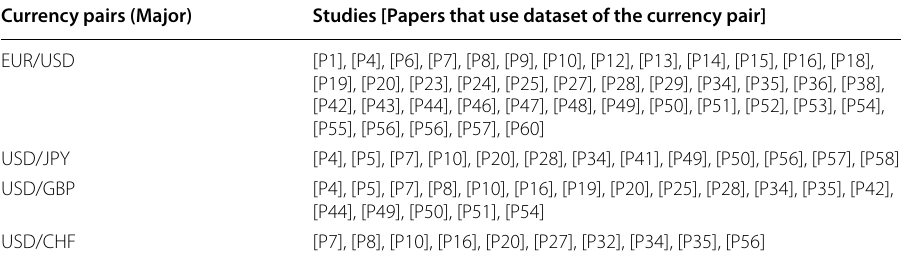
Table 7 Major currency pairs and corresponding studies that used its dataset Currency pairs (Major) Studies [Papers that use dataset of the currency